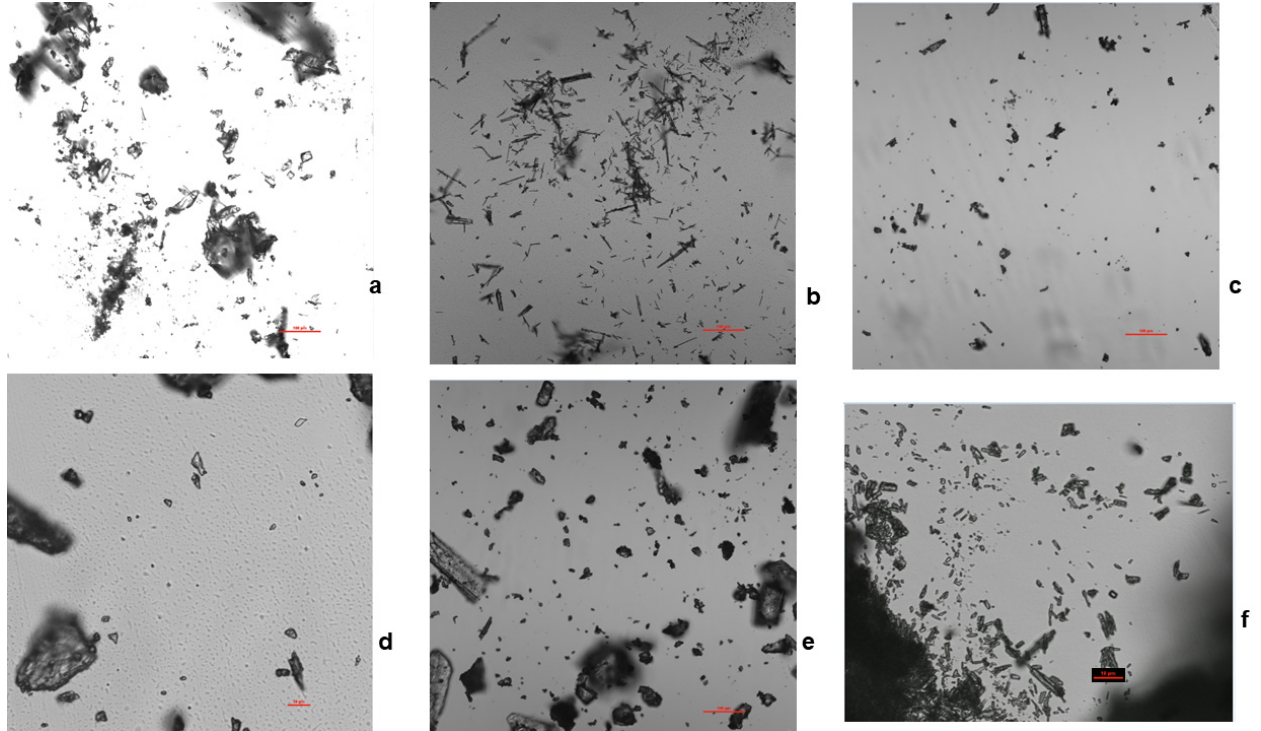
Figure 6. Confocal microscope morphology of particle shapes for bedaquiline salts. At 20× magnifi- cation, the images for the HCL and salicylate salts were obtained at a scale of 10 µm; the free base and other salts were measured with a scale of 100 µm. ( a ) The free base consisted mostly of plates, ( b ) benzoate took the form of blades and needles, ( c ) nicotinate was observed as plates and chunks, ( d ) HCl was blades and plates, ( e ) malonate was blades and plates, and ( f ) salicylate was plates and blades .